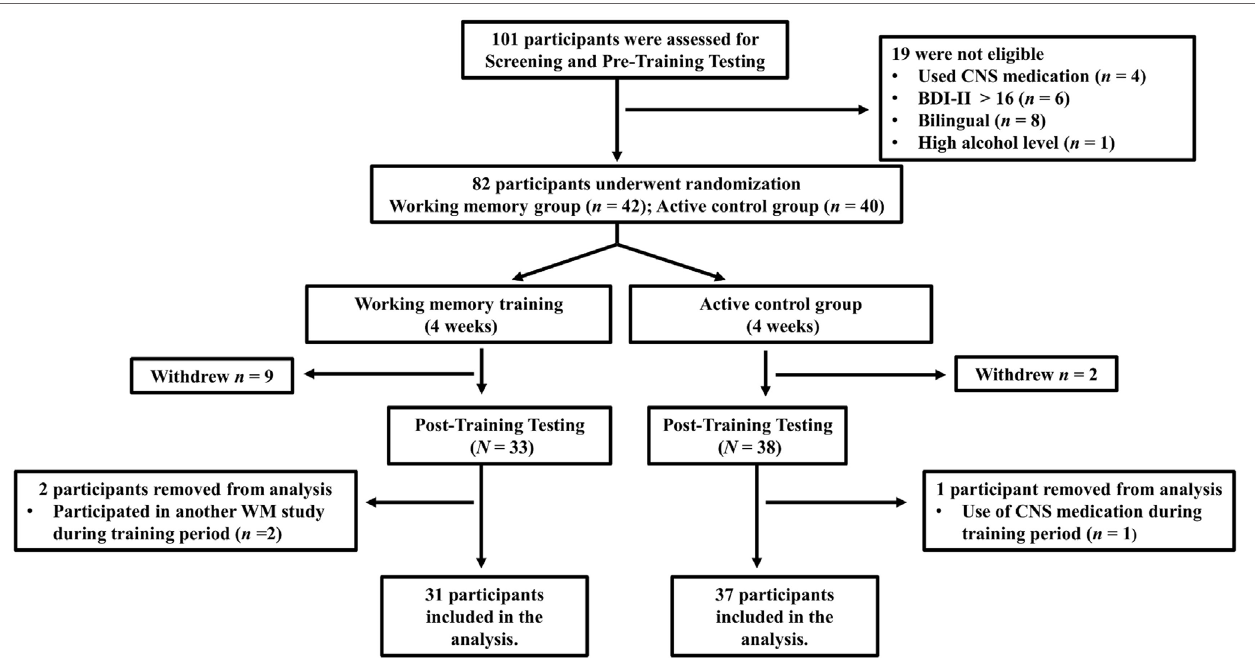
FigUre 1 | A flowchart of the study and dropout rates at the different stages